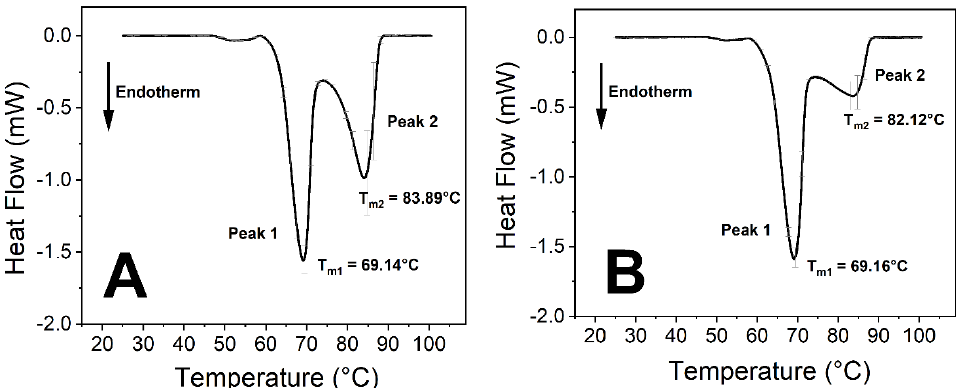
Figure 3. Thermal analysis of untreated and SARS-CoV-2-treated human anticoagulated whole blood samples. ( A ) Control: 50 h of incubation at 37 °C. ( B ) Treated with SARS-CoV-2 and incubated for 50 h at 37 °C. The DSC data represent the mean ± SD of at least four independent measurements ( n ≥ 4).